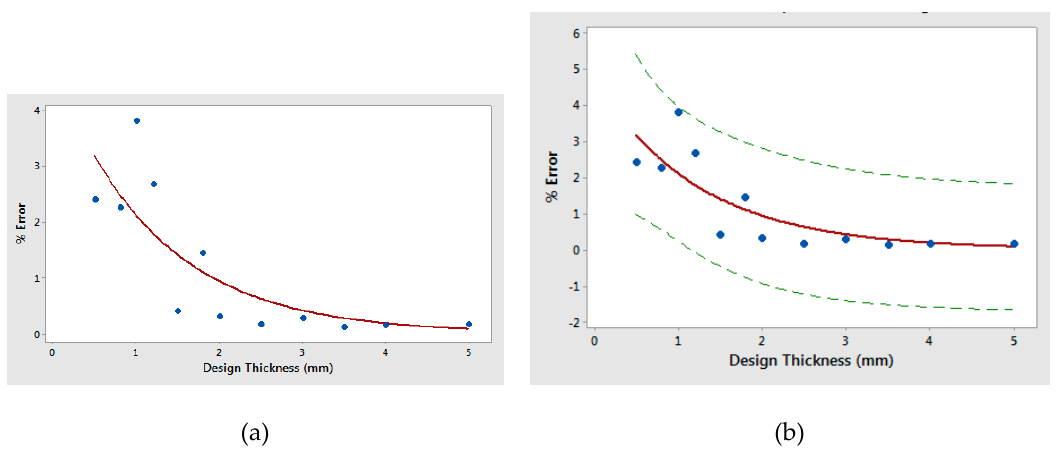
Figure 7. ( a ) Fitted line plot for a regression model. Sample thickness and % error in the thickness of developed samples decrease exponentially with increasing thickness. ( b ) Prediction plot showing the values falls within the 95% prediction interval. The central red line is fitted line, and the outer blue lines represent 95% prediction interval.